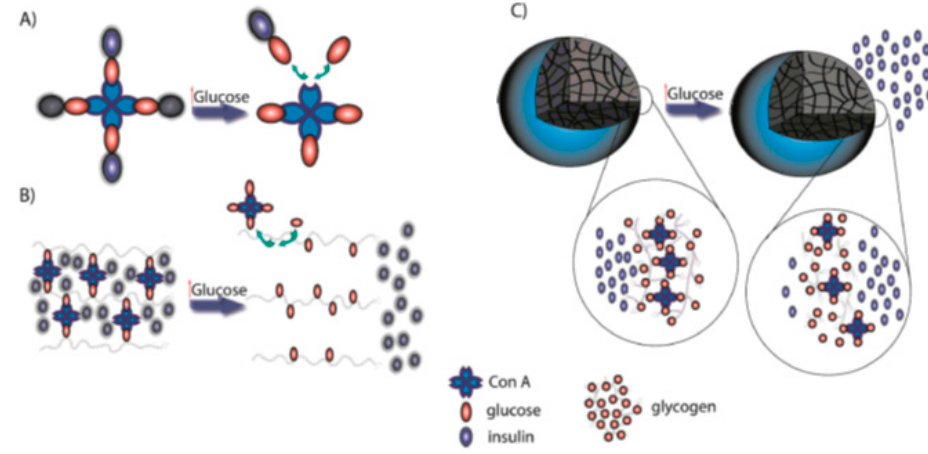
Figure 9. Schematic representing ( a ) ConA, with an affinity to glucose, with four binding sites for glucose or glucose-linked molecules. ( b ) When an increase in blood glucose levels (BGLs) occurs, ConA binds to free glucose and releases its bonds to the matrix polymer, resulting in a separation of the polymeric chain. The hydrogel goes from gel to sol, with insulin being released. ( c ) With high BGLs, attachments between ConA and glycogen are destroyed, and the outer part of the carrier swells, with insulin being released (adapted with permission from Reference [4]).